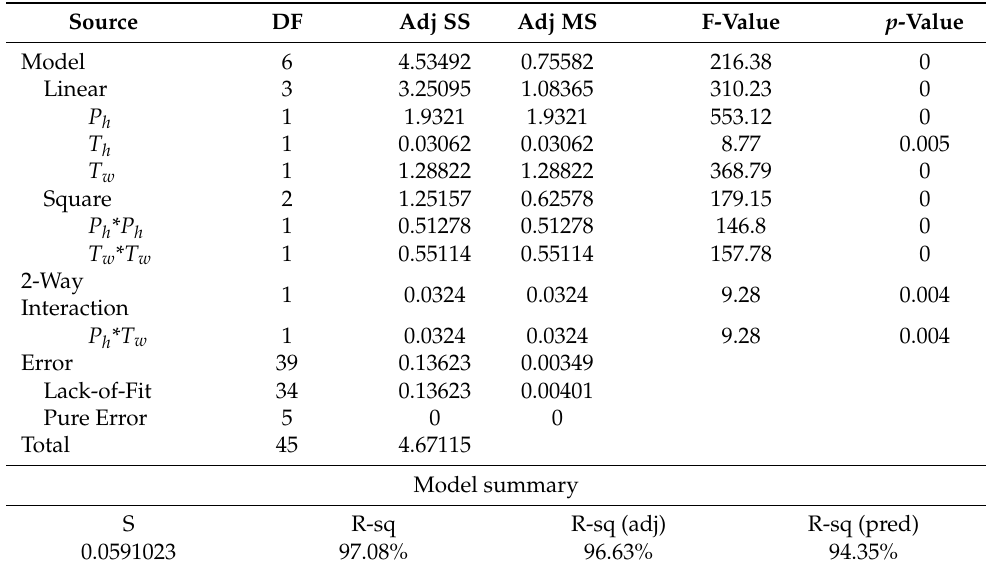
Table 7. Analysis of variance of the magnetic flux density.